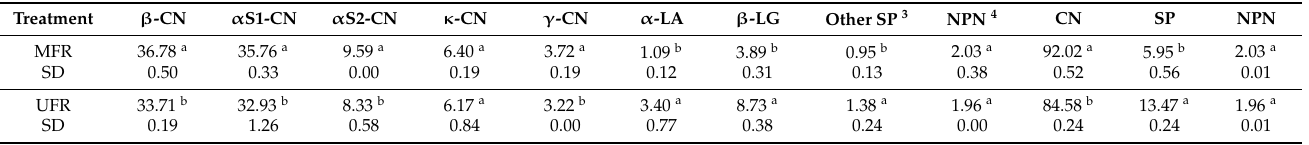
Table 7. Mean ( n = 3) of individual protein fractions observed in capillary gel electrophoresis of retentate (MFR 1 and UFR 2 ) produced during microfiltration and ultrafiltration of skim milk using polymeric spiral-wound membranes. Treatment